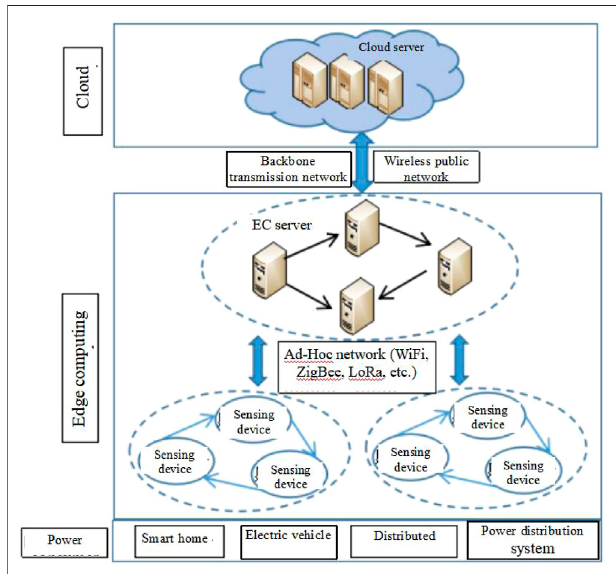
FIGURE 1 | Edge computing architecture of a UPIoT smart sensing